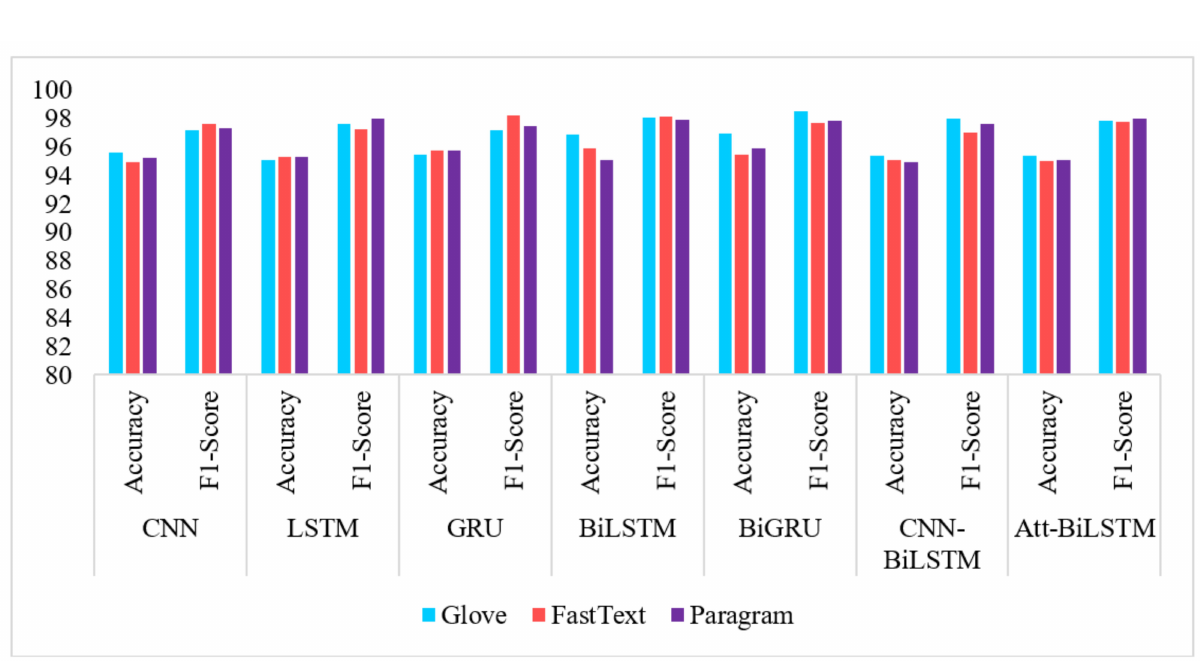
Figure 10. Performance comparison of seven shallow neural networks on Wikipedia Attack